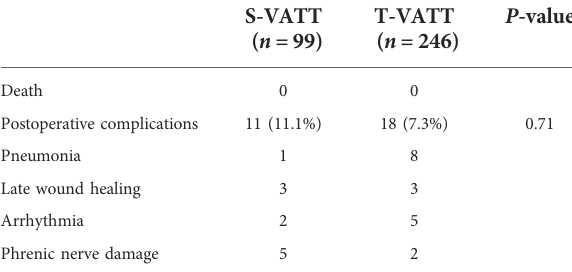
TABLE 5 Comparison of postoperative complications in the two